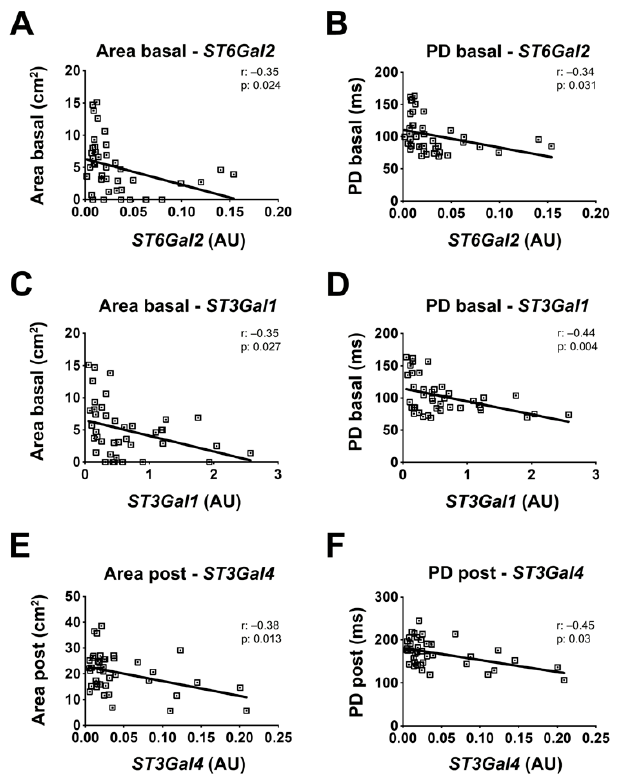
Figure 5. Sialyltransferases mRNA levels are correlated with BrS clinical features. The correlation between sialyltransferases gene expression and clinical features was analyzed by comparing the RNA expression levels of ST6Gal2 , ST3Gal1 , and ST3Gal4 with different clinical characteristics of BrS patients. Correlation between ST6Gal2 mRNA levels and basal pathological substrate area ( A ) and PD ( B ). Correlation between ST3Gal2 mRNA levels and basal pathological substrate area ( C ) and PD ( D ). Correlation between ST3Gal4 mRNA levels and post-ajmaline pathological substrate area ( E ) and PD ( F ). BrS: N = 41. Each square in the graphs represent a single BrS patient. The statistical significance of the correlation was evaluated using the Pearson’s r coefficient and the p value.